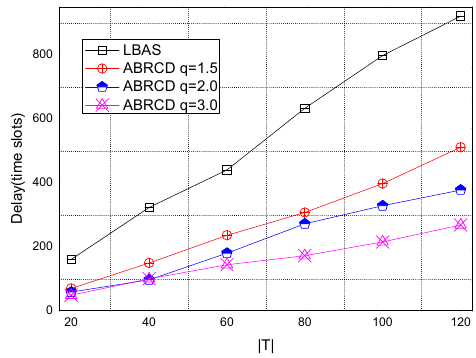
Figure 40. The impact of | T | with fixed network size = 600 on delay.